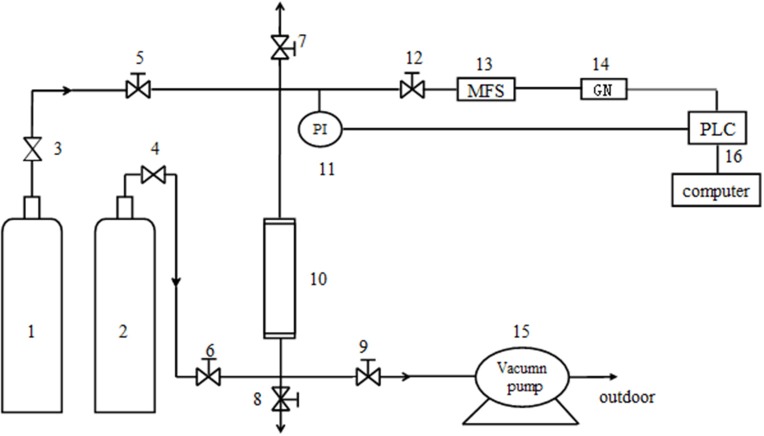
The dynamic test device. 1. He cylinder; 2. Mixture cylinder of CH4/N2; 3, 4. Pressure reducing valve; 5, 6, 7, 8, 9 and 12. Needle-type valve; 10. Absorbing tower(16mm*320mm); 11. Pressure probe; 13. Mass flow controller; 14. Gas analyzer; 15. Vacuum pump; 16. Windows control center (Copyright©1994–1997 SIEMENS, AG).